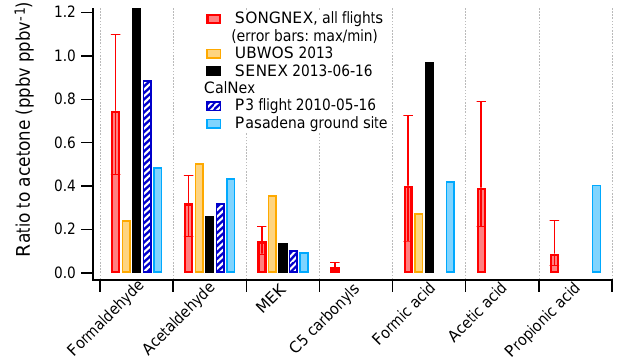
Figure 4. Average mixing ratios of oxygenates relative to ace- tone. Formaldehyde is from LIF instrument, and formic acid from HNO 3 –HCOOH CIMS. (For CalNex and SENEX instrumentation information, see https://www.esrl.noaa.gov/csd/field.html).